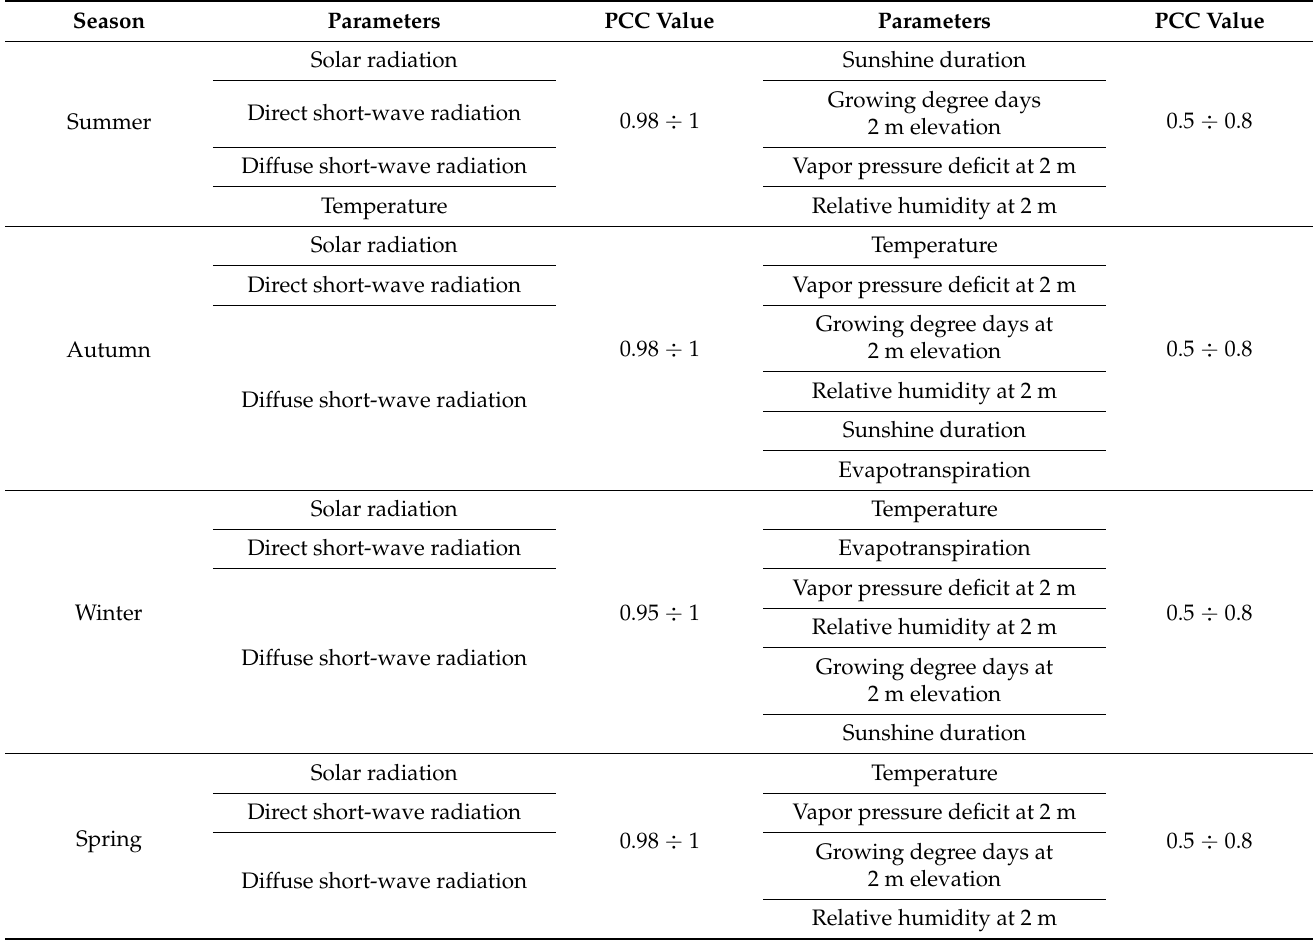
Table 4. Parameters that influence solar radiation in the different seasons (classified into two different classes according to PCC value) and used for the solar radiation forecasting process by LSTM and ANFIS